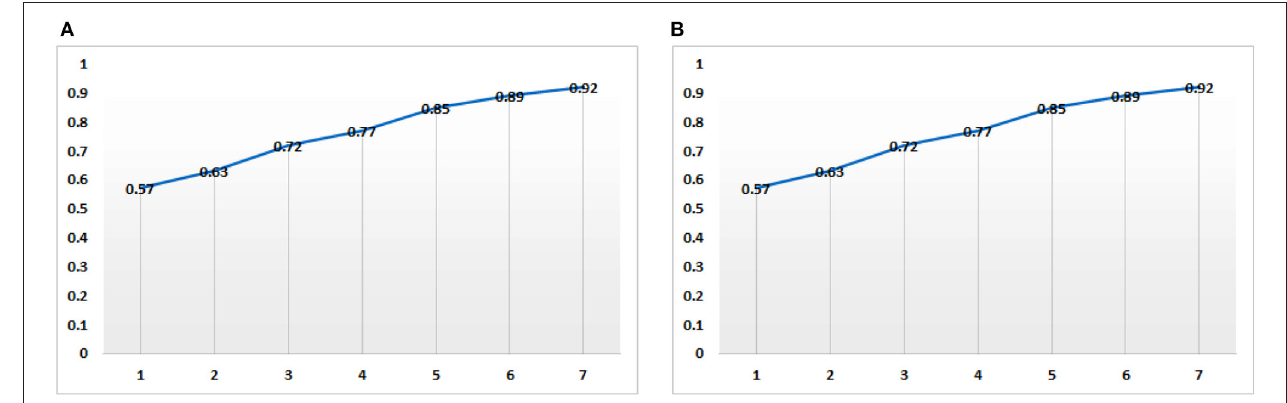
FIGURE 1 | Change trend of mental disease risk prediction accuracy along the change of term volumes (KB) based on Twitter (A) and Sina (B)